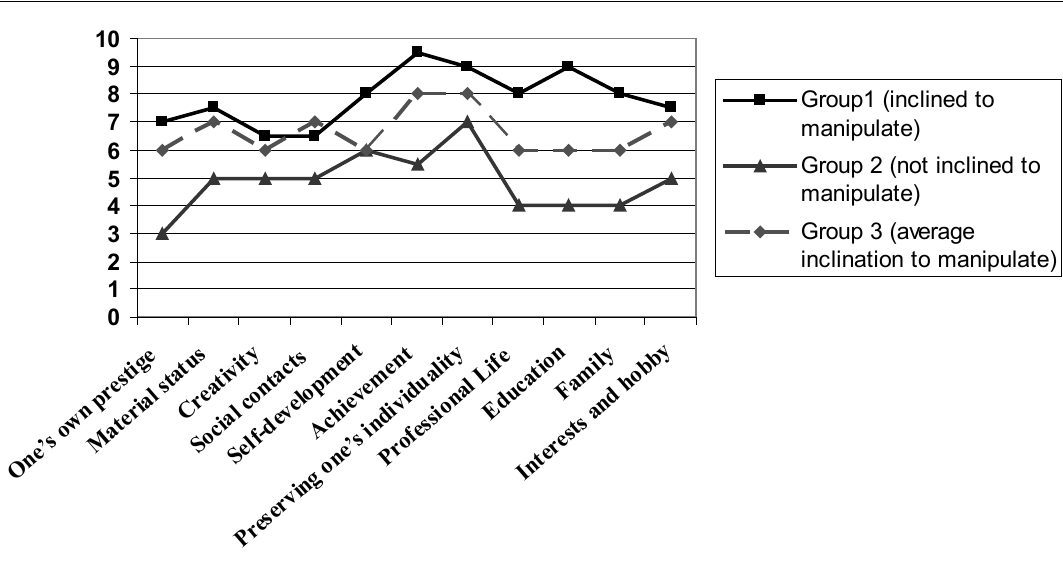
Fig. 2. Comparative diagram of the study (cid:222) ndings according to the Questionnaire of terminal values by Ivan